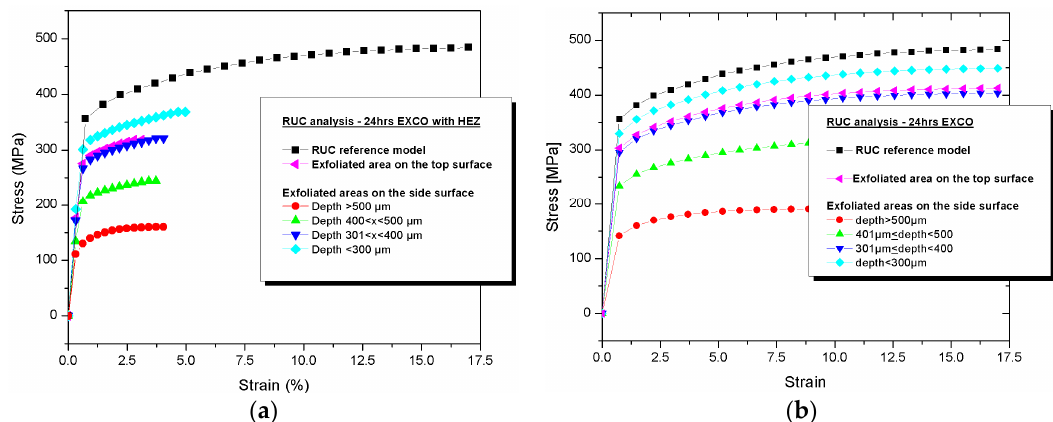
Figure 8. RUC analyses’ results for the exfoliated areas of the top and side surfaces after 24 h of exposure ( a ) accounting for geometrical features of corrosion and the HEZ and ( b ) accounting only for geometrical features of corrosion.